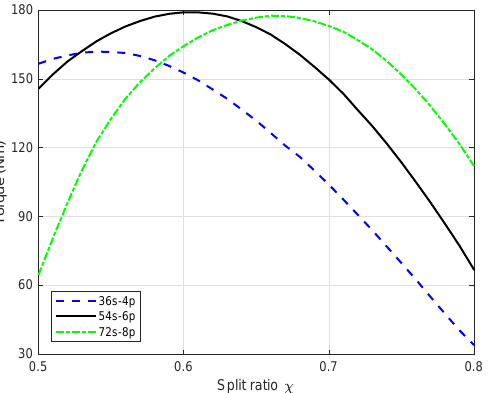
Figure 8. Variations in torque with split ratio for the SynRMs with different slot–pole combinations and q = 3.